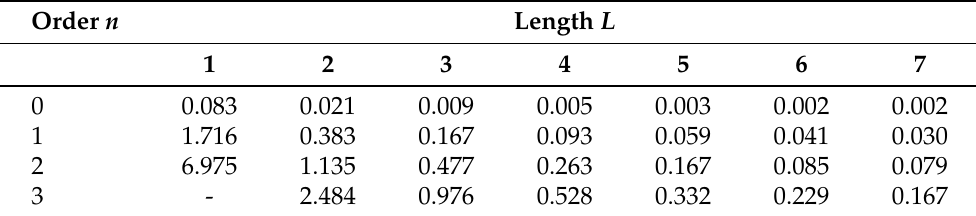
Table 6. Maximum difference between the linear and lowest-order non-linear approximations of the deformation of the buckled cantilever beam for several lengths of the beam and for the first four orders of the buckling load. The parameter b is equal to 0.1. The results are multiplied by 100. Order